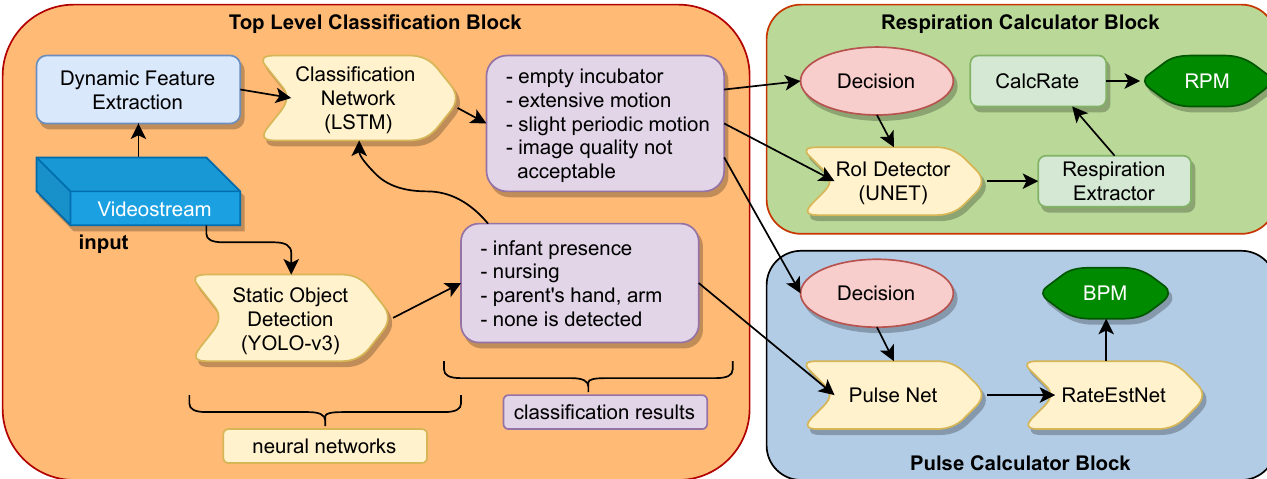
Figure 1. Information flow between the different algorithmic components. From the Videostream input 14 features are extracted via Dynamic feature extraction and Static object detection . The concatenated feature vector is processed by the Classification network , which outputs categories and a decision whether to run Respiration Calculator Block and Pulse Calculator Block . The former runs based on this decision and receives the videostream. UNET segments images, while Respiration Extractor outputs the wave-like respiration signal and CalcRate calculates the breathing rate. The Pulse Calculator Block runs based on the decision, receives the videostream and the bound box of the infant, if detected. Pulse net uses its attention mechanism, outputs the wave-like pulse signal and RateEstNet calculates the pulse rate. Alarm signals (e.g., apnea) and additional statistics can be extracted from the classification and the numerical